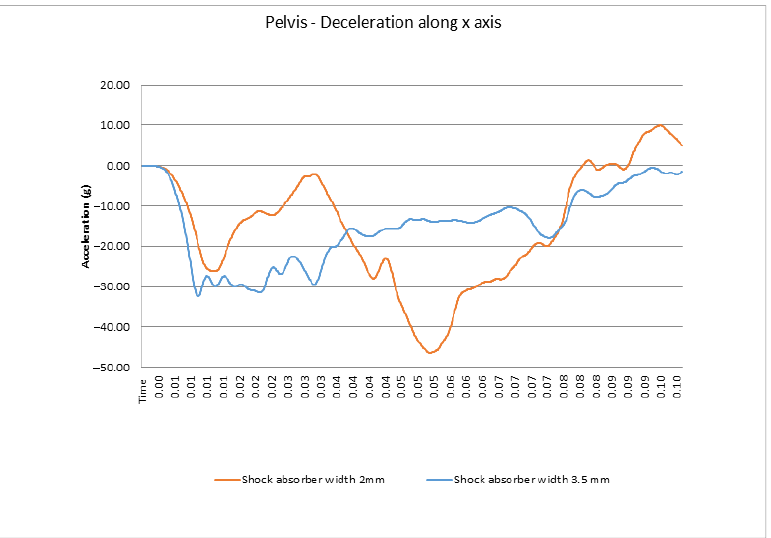
Figure 17. Acceleration registered by a virtual accelerometer in the pelvis, v = 13 m/s.